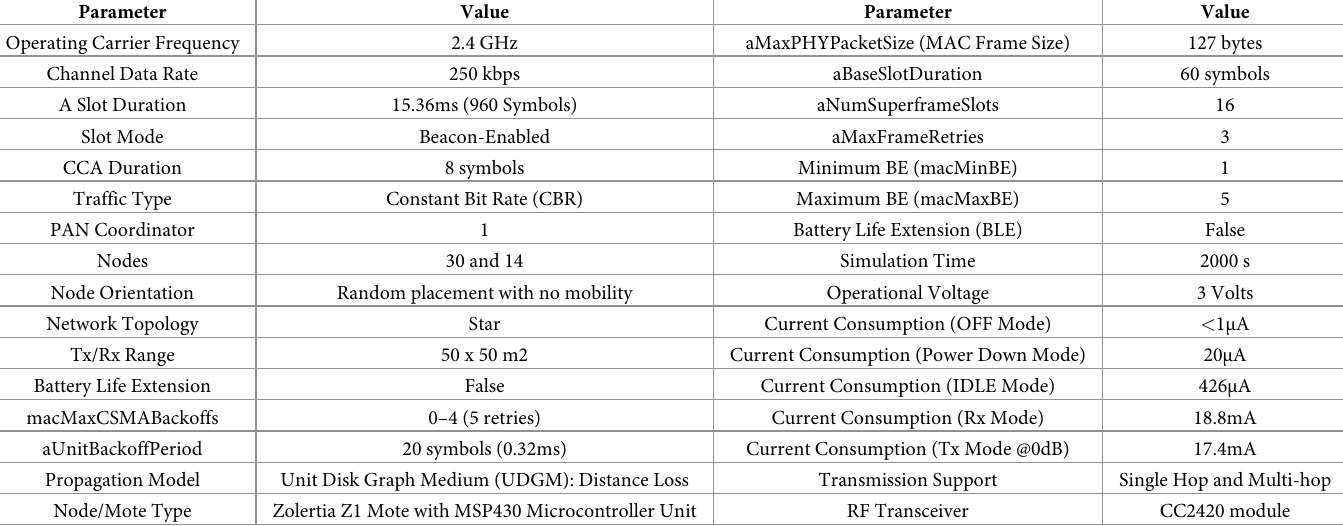
Table 5. Simulation configuration and